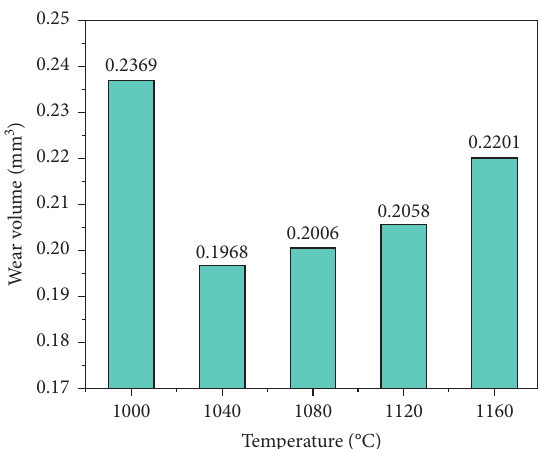
Figure 5: Wear volume of 2205 duplex stainless steel at different solution temperatures.